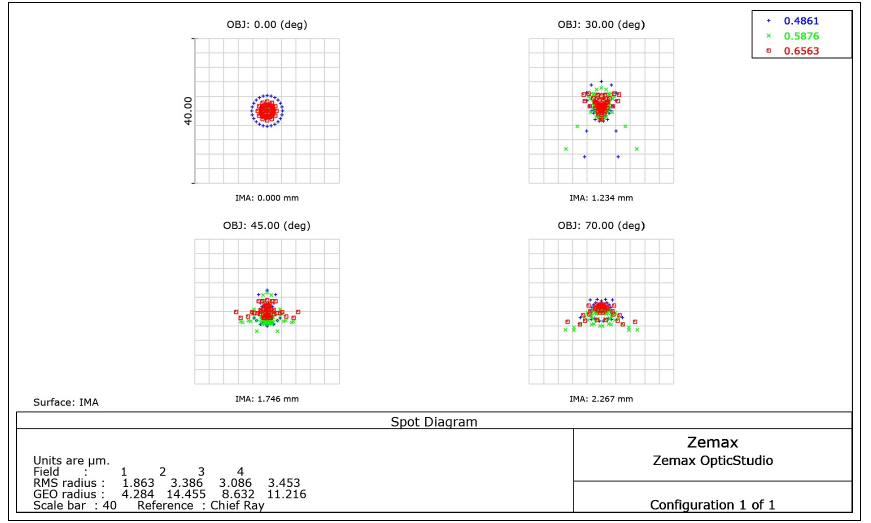
Figure 6. Spot diagram of the optimized system.